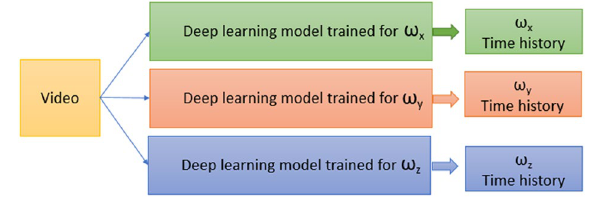
Figure 4. Combined deep learning